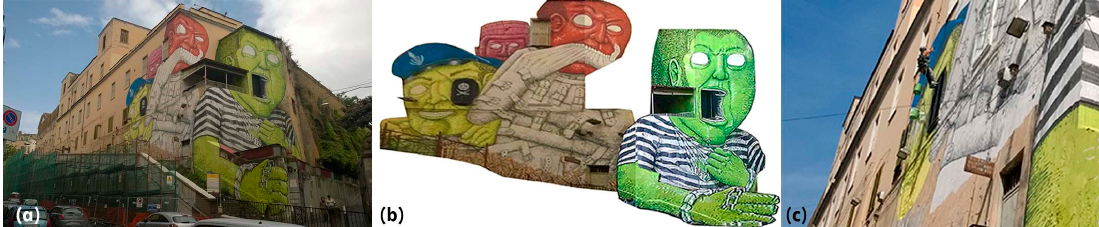
Figure 6. Blu: ( a ) Murales on Ex OPG Occupato Je so’ pazz ; ( b ) drawing unfolded by Vincenzo Cirillo; ( c )